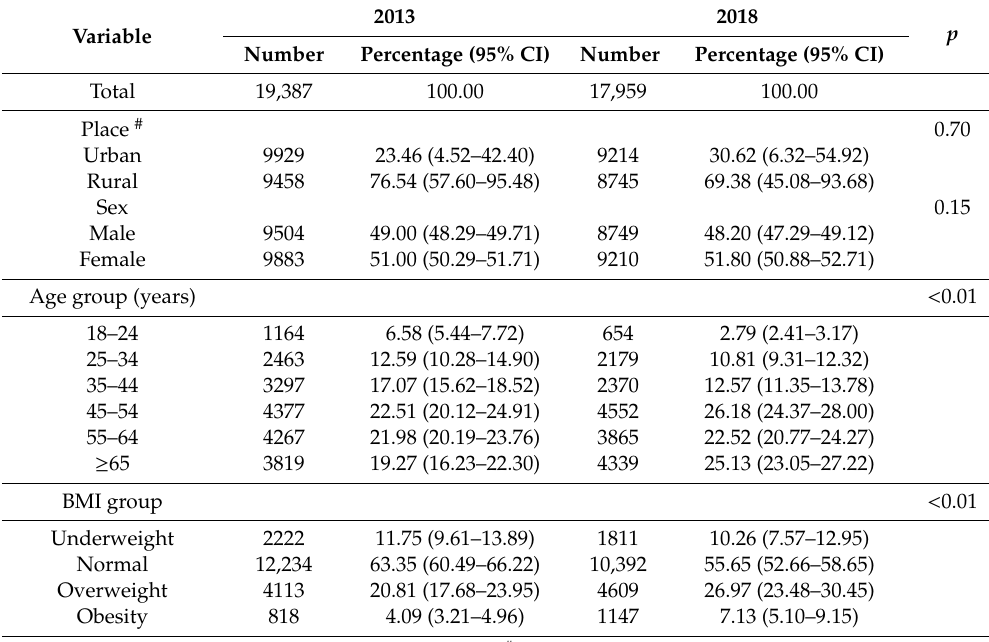
Table 1. Characteristics of respondents in health service household interviews of 2013 and 2018 in Hunan Province,